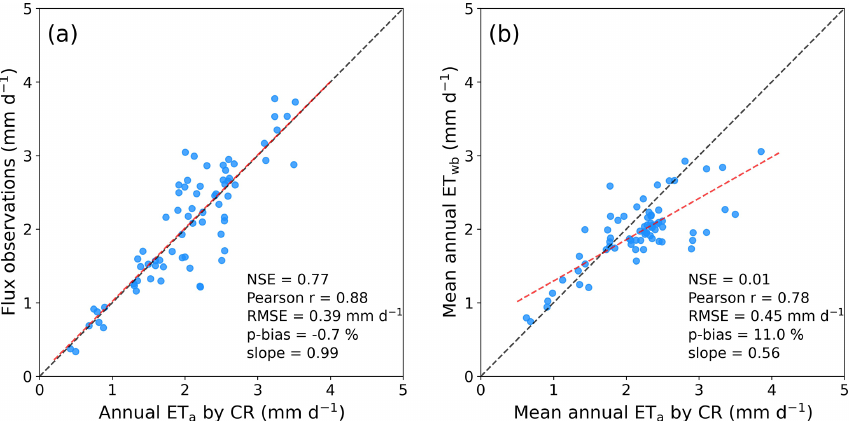
Figure 3. Same as Fig. 2 except α e = 1 .